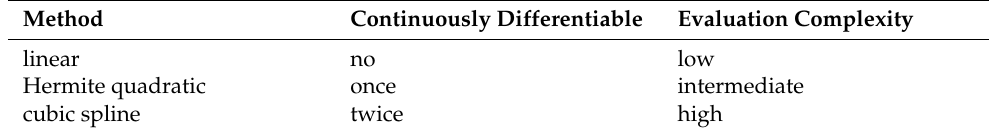
Table 2. Comparison of interpolation